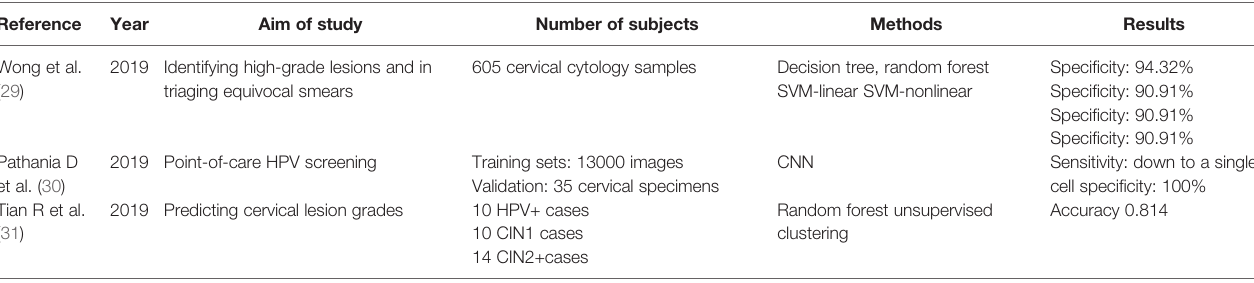
TABLE 2 | Application of AI in HPV